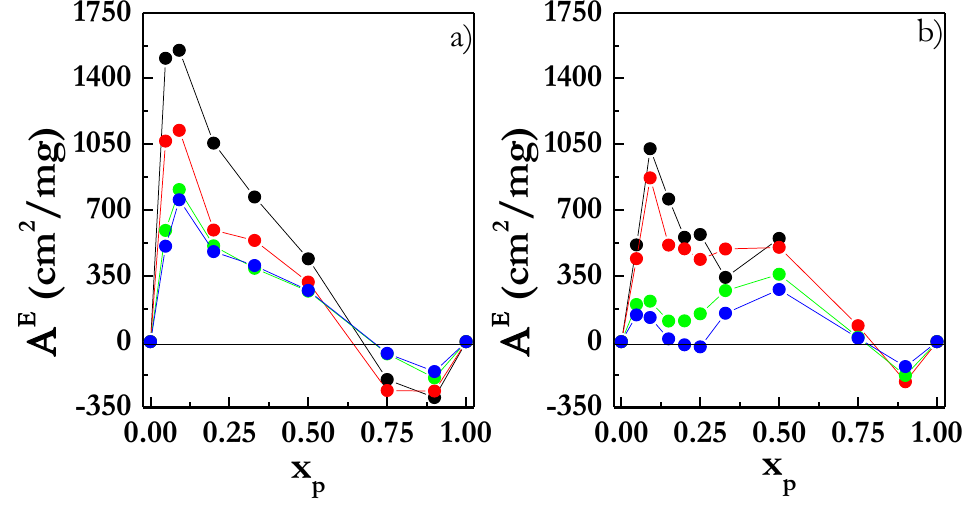
Figure 7. Dependences of the A E on the particle weight fraction, x p , for different values of the surface pressure Π for DPPC monolayers upon incorporation of CB ( a ) and SiO 2 ( b ): ( ―●― ) 3 mN/m, ( ―●― )